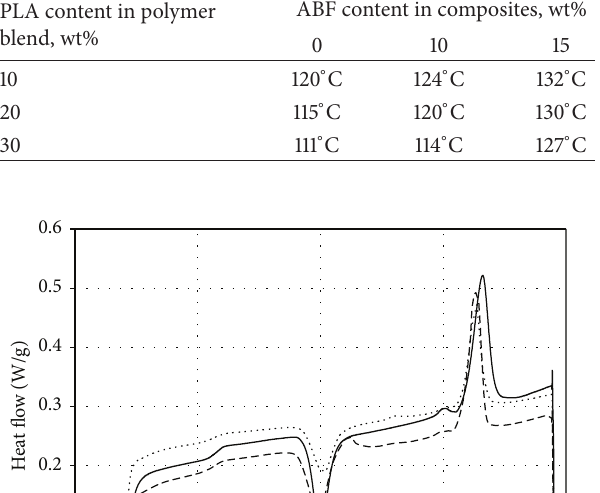
Figure 4: Storage modulus of polymer blends and composites at 25 ∘ C, varying PLA content.